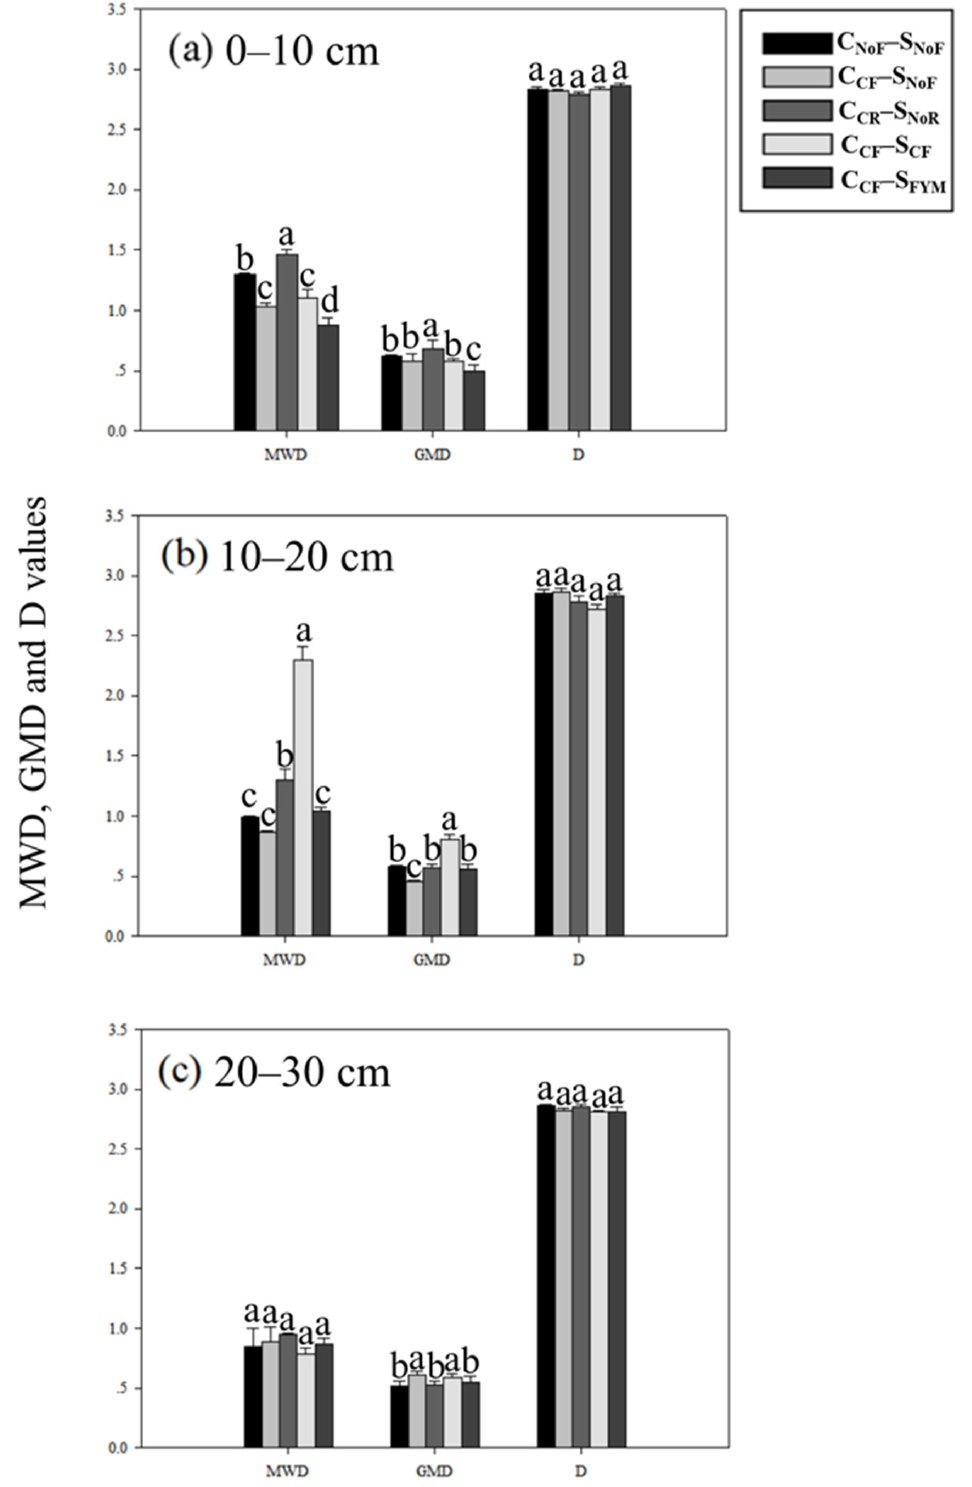
Figure 2. MWD, GMD, and D values at different layers. Note: Different lowercase letters represent significant differences among different treatments at the same soil layer (Tukey’s HSD test, p < 0.05).